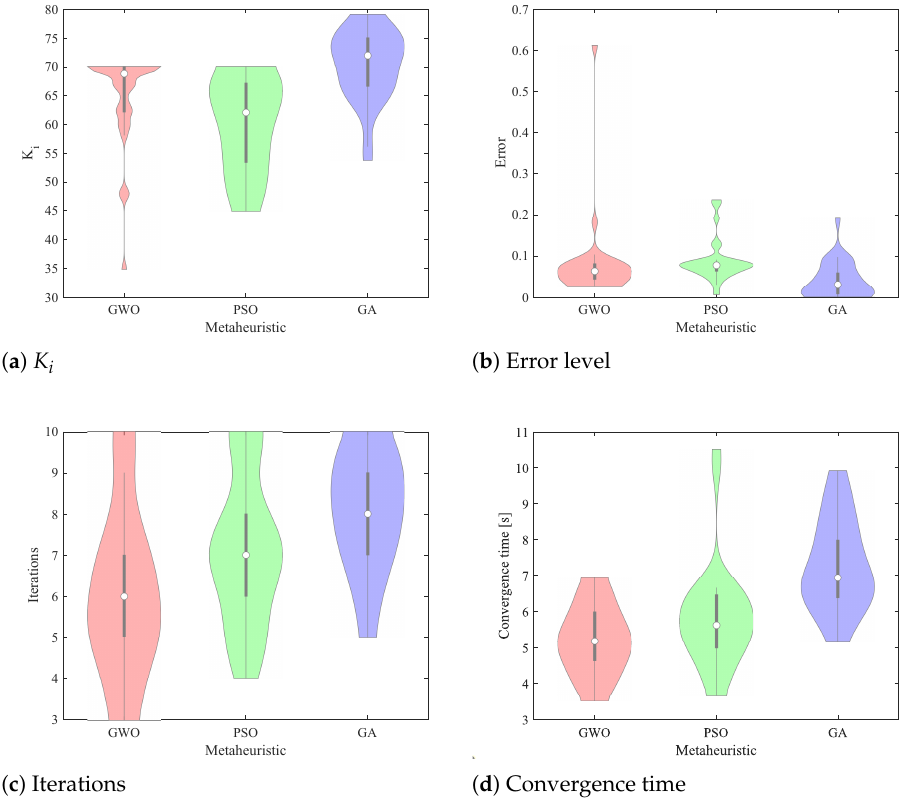
Figure 15. Performance metrics of 30 controllers for the IBC and tuned with each one of the considered